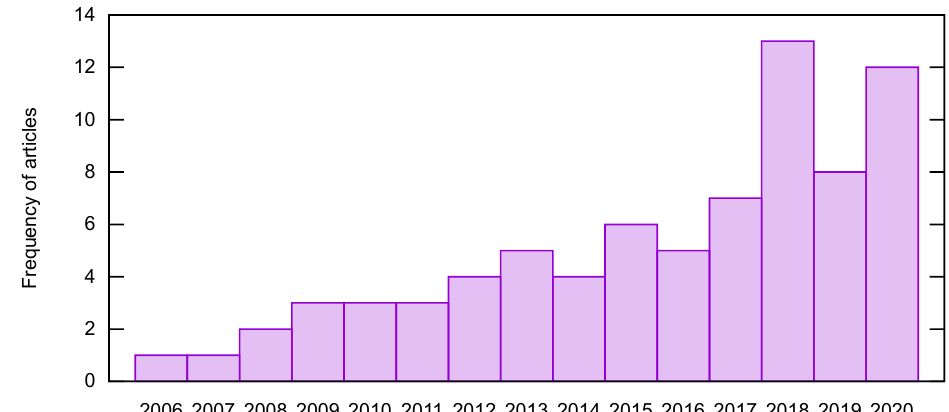
Figure 4. The frequency of articles over time, illustrating the historical trend of the number of papers published with relevant hybrid system dynamics (SD)–agent-based (AB) (SD-AB) modeling